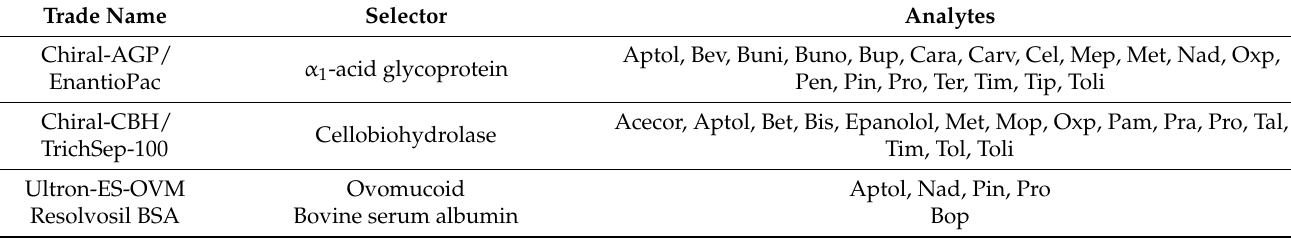
Table 8. Types of protein-based CSPs for the enantioseparation of β -blockers